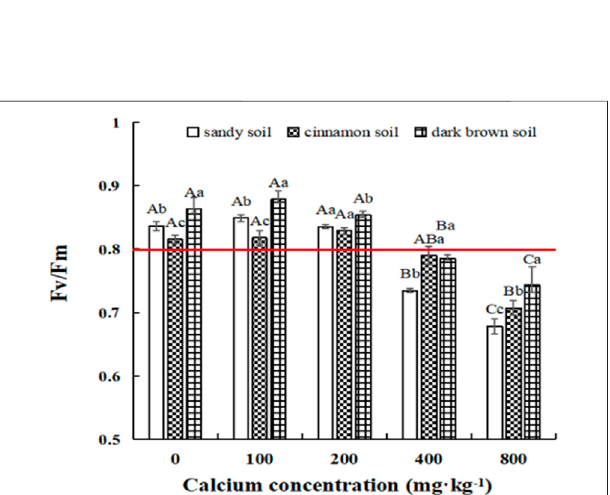
FIGURE 4 | Effect of exogenous calcium on photosynthates of Mongolian pine seedlingsin different soil types. Note: Each column shows the average value ± SE, n = 3. Different capital letters indicate the difference between different calcium concentrations under the same soil type, and different lowercase letters indicate the difference between different soil types under the same calcium concentration ( p < 0.05).